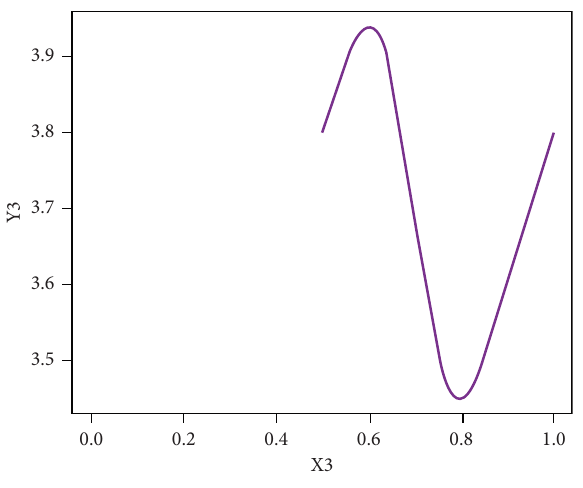
Figure 7: Stratum-III (population-2).